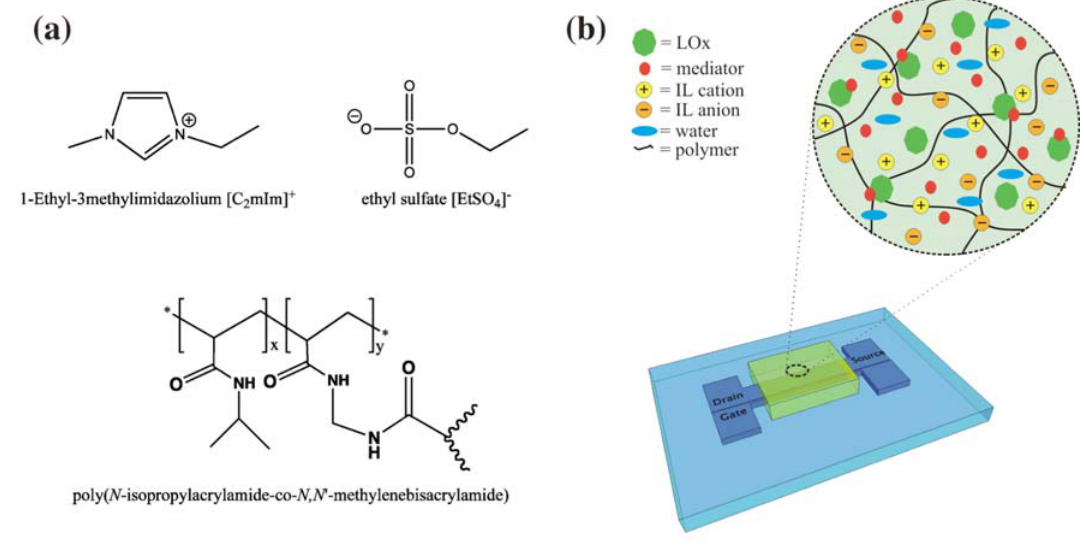
Figure 9. ( a ) Ionogel components and ( b ) a schematic representation of the organic electrochemical transistor (OECT) device with ionogel/enzyme mixture [20] (Reproduced by permission of The Royal Society of